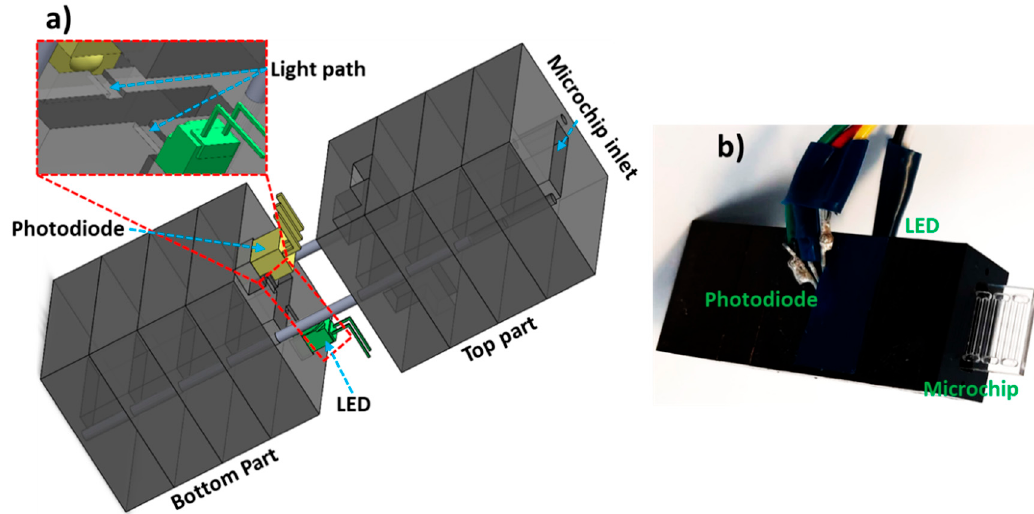
Figure 1. Optical flow cell overview. ( a ) Schematic of the portable flow cell illustrating LED, photodiode, light path and microchip inlet. ( b ) Photograph of the flow cell with a microchip inserted into the inlet. Multiple PMMA pieces (5 mm thickness) were micromilled and combined via alignment pins. Bottom par houses the LED and photodiode while the top part allows the electrical connections to the microcontroller.